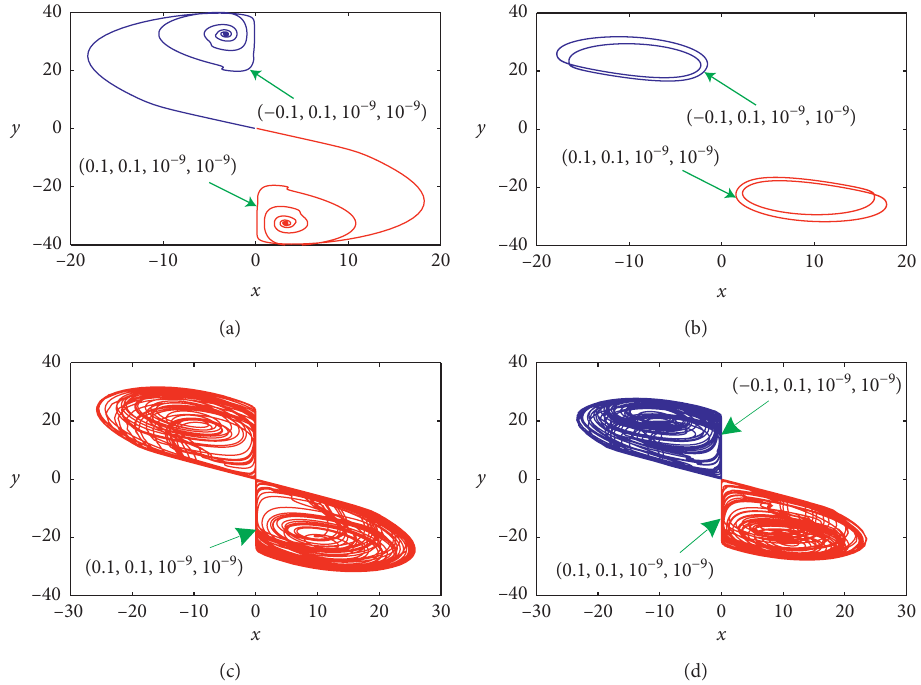
Figure 5: Phase plane plots in the x – y phase plane for different d and f . (a) Coexisting point attractors for d � 0.1 and f � 1.88. (b) Coexisting limit cycles with period-2 for d � 0.35 and f � 1.88. (c) Double-scroll chaotic attractors for d � 0.5 and f � 1.88. (d) Coexisting single-scroll chaotic attractors for d � 0.5 and f � 3.